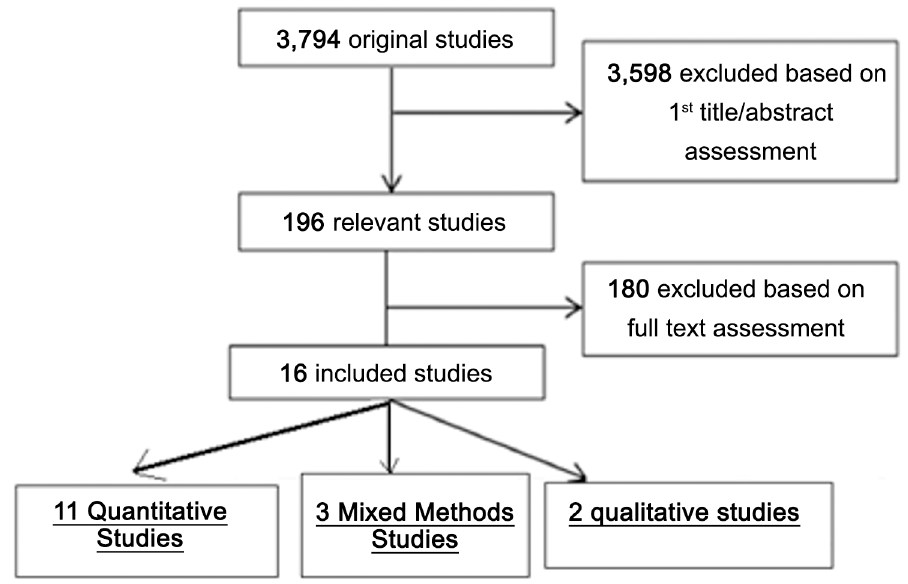
Fig 1. Flow diagram of included